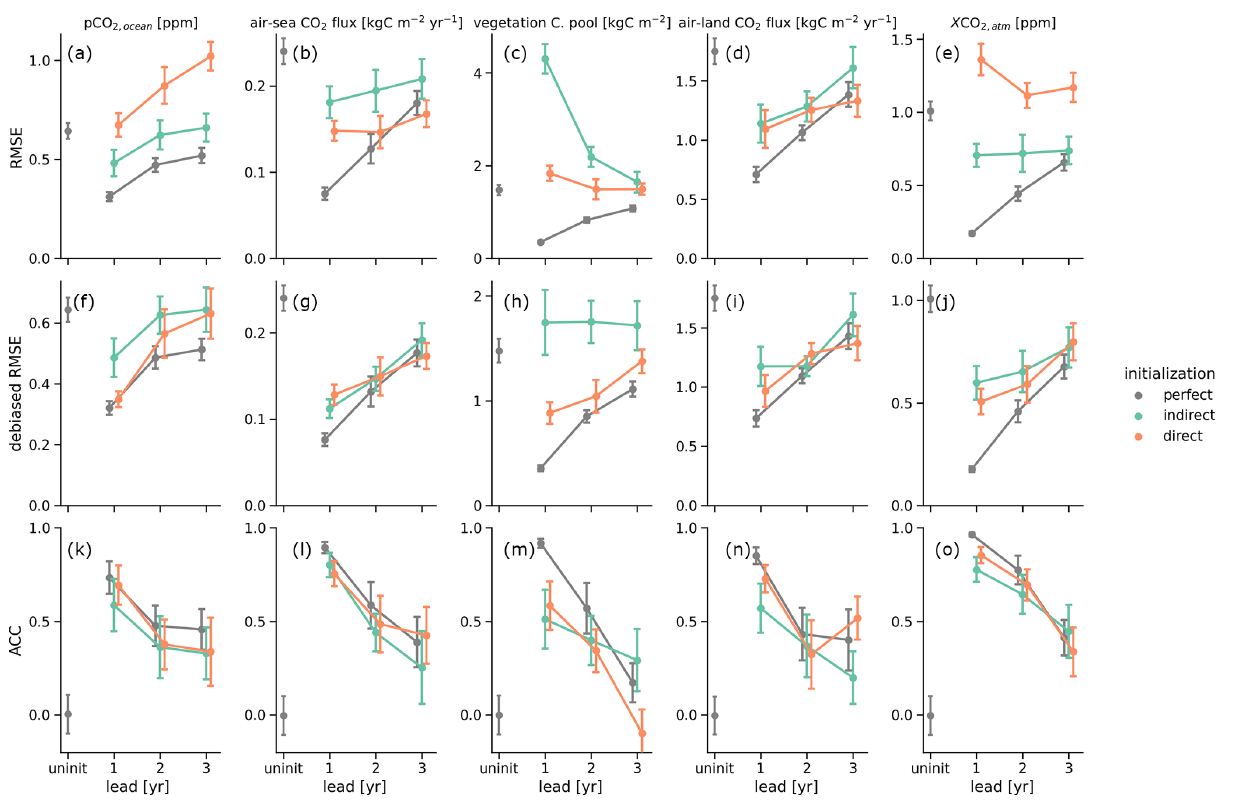
Figure 6. Predictive skill measured by (a–e) root-mean-square error (RMSE), (f–j) RMSE after bias reduction, and (k–o) anomaly corre- lation coefficient (ACC) between the initialized ensemble mean and the target as a function of lead year for different initialization setups: perfect indicating no reconstruction and hence perfect initial conditions to predict the target (gray), indirect (green), and direct (orange) reconstructions. Columns show global variables for the ocean carbon cycle, i.e., (a) oceanic surface p CO 2 and (b) air–sea CO 2 flux; for the land carbon cycle, i.e., (c) total land carbon pools and (d) air–land CO 2 flux; and in the atmosphere, i.e., (e) atmospheric CO 2 mixing ratio. Initialized ensembles are resampled with replacement ( N = 500) along the initialization dimension to account for initialization sampling un- certainty (see Spring and Ilyina, 2020), where error bars show the resampled initialization skill uncertainty ( ± 1 σ ). Uninitialized ensembles, shown at lead 0, are resampled from the target control simulation and show the reference skill without